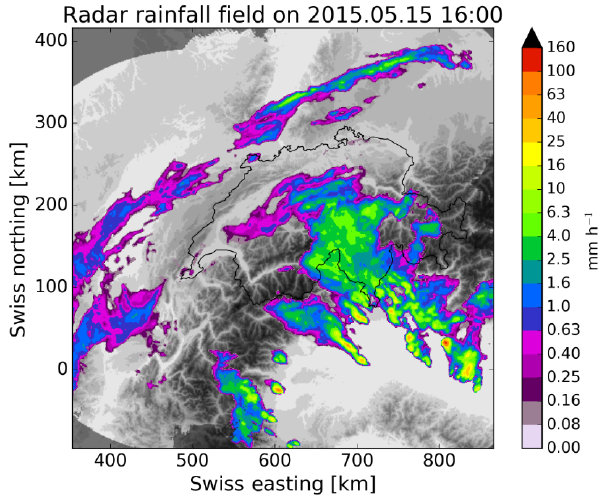
Figure 1. Example of non-stationarities in a radar rainfall field of 512km × 512km centred over Switzerland. Two distinct anisotropies coexist in the same image, whereas convection devel- ops only to the south of the